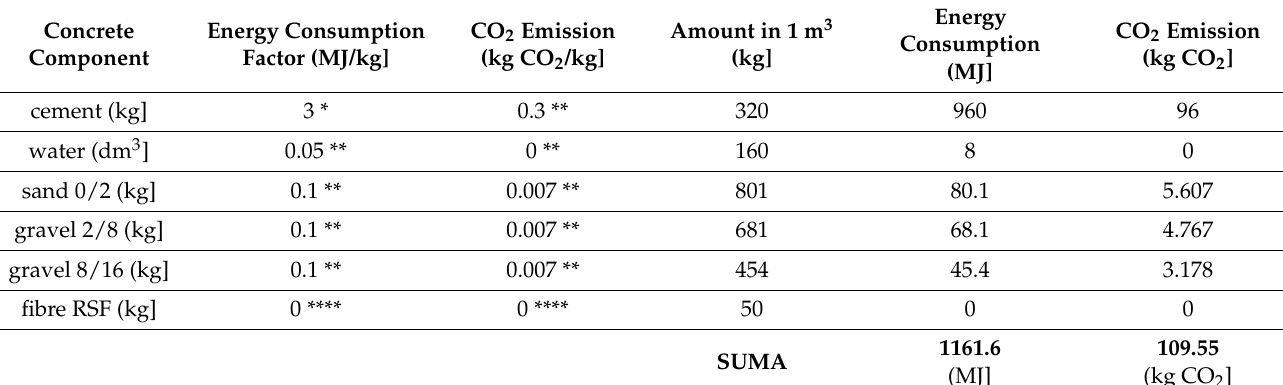
Table 9. Determination of energy consumption and CO 2 emissions for 1 m 3 of fibre concrete with RSF fibres. Concrete